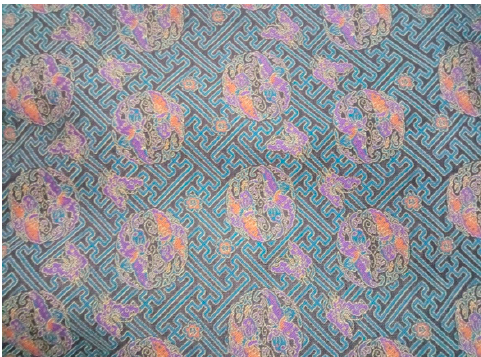
Figure 13. The other Song Brocade fabric with Ag-PA yarns.